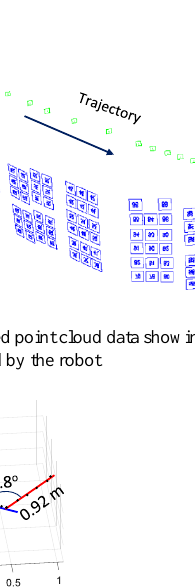
Figure 15. Comparison of the positioning of each leg w.r.t. the CAD.